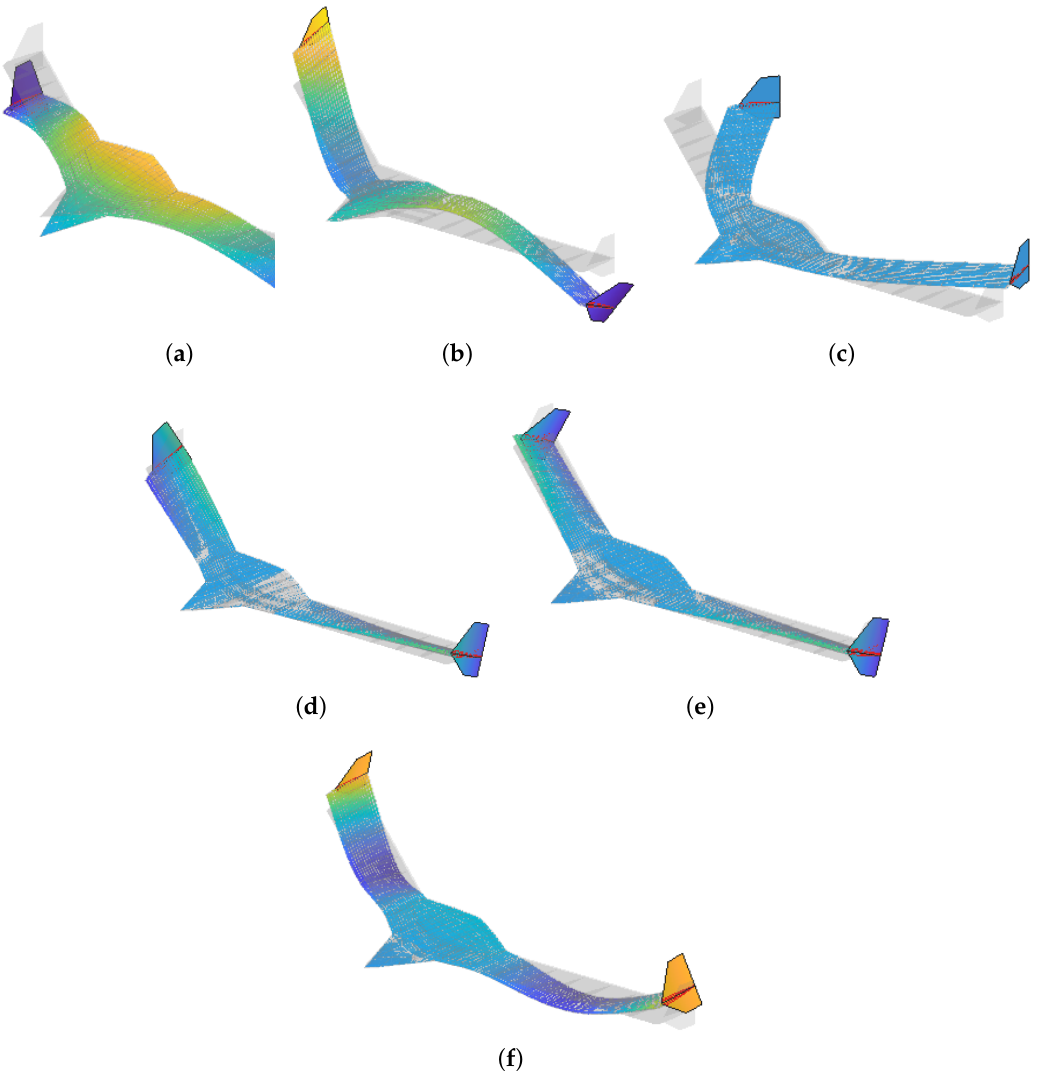
Figure 3. Elastic mode shapes of the model. Captions indicate their natural frequencies. ( a ) f 1 = 5.83 Hz. ( b ) f 2 = 8.83 Hz. ( c ) f 3 = 13.45 Hz. ( d ) f 4 = 19.82 Hz. ( e ) f 5 = 20.09 Hz. ( f ) f 6 = 23.72